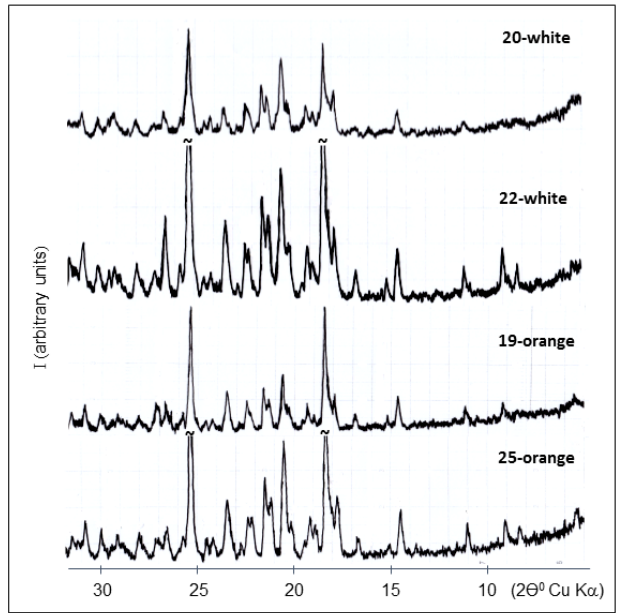
Figure 5. XRD patterns obtained for white and orange samples. All peaks are from pickeringite/halotrichite. Table 1. JCPDF cards for minerals (obtained with radiation Cu K α ) from the halotrichite group (the three more intense lines are assigned in bold): halotrichite, FeAl 2 (SO 4 ) 4 · 22H2O (number 39-1387); pickeringite, MgAl 2 (SO 4 ) 4 · 22H 2 O (46-1454); apjohnite, MnAl 2 (SO 4 ) 4 · 22H 2 O (29-0886);